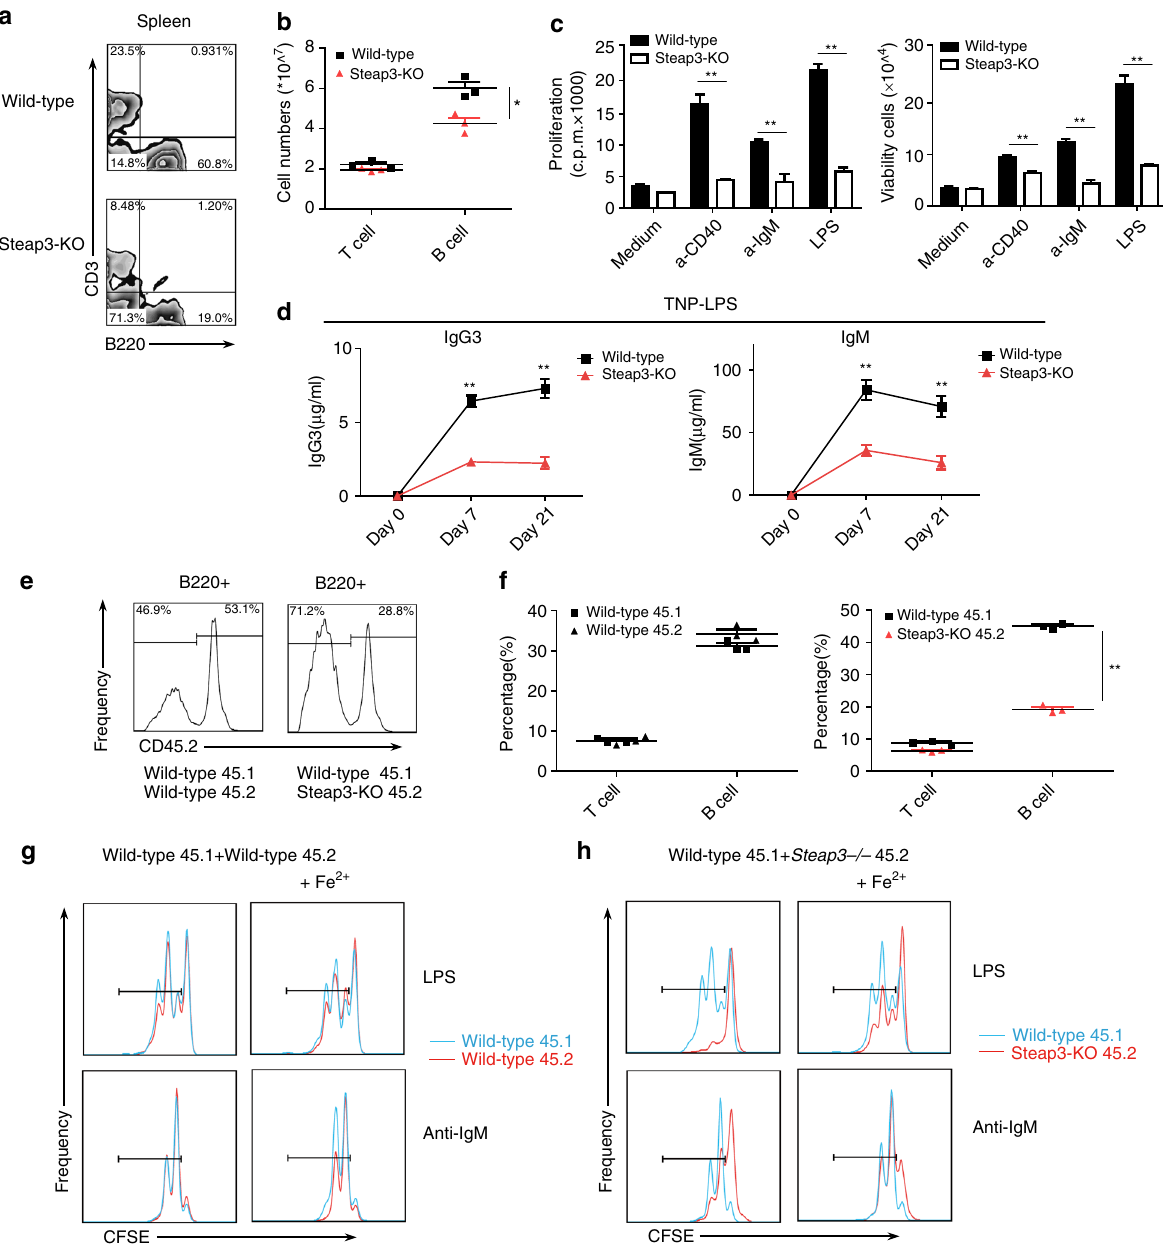
Fig. 3 Defective mature B-cell population and proliferation in Steap3-KO mice. a Flow cytometry of splenocytes from wild-type and Steap3-KO mice was used to identify CD3 + T cells and B220 + B cells. b Statistics for the numbers of splenic B and T cells in the two groups (mean ± SEM of three mice per group). c Wild-type or Steap3-KO splenic B cells were stimulated with anti-CD40 (1 μ g/ml), anti-IgM (10 μ g/ml), or LPS (2 μ g/ml), and proliferation was assessed by [ 3 H] thymidine incorporation ( b , top). Viable B cells were counted 48 h after stimulation ( b , top). d ELISA to check antigen-speci fi c antibody responses of wild-type and Steap3-KO mice 7 days and 21 days after immunization with TNP-LPS (the data represent the mean ± SEM of four mice per group). CD45.1 + wild-type bone marrow cells were mixed 1:1 with CD45.2 + wild-type or Steap3-KO bone marrow cells and cotransferred into